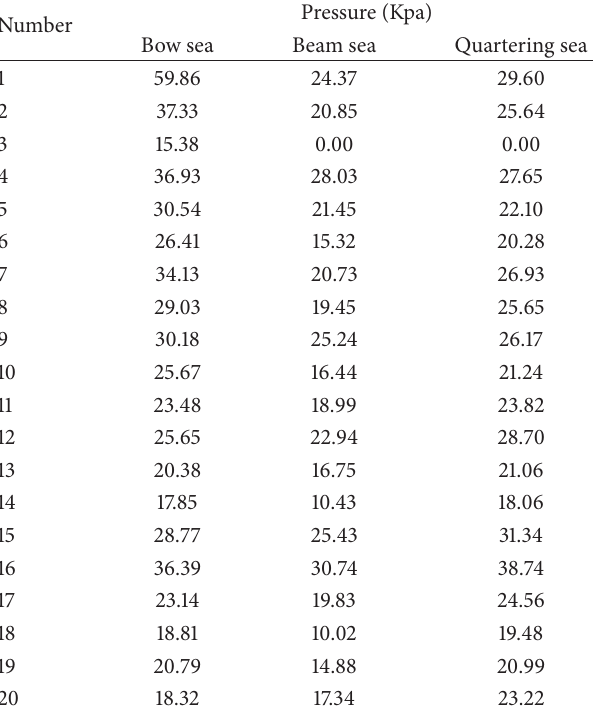
Table 4: Pressure in different